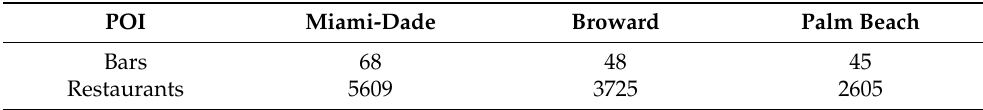
Table 2. Numbers of bars and restaurants in Miami-Dade, Broward, and Palm Beach counties dur-